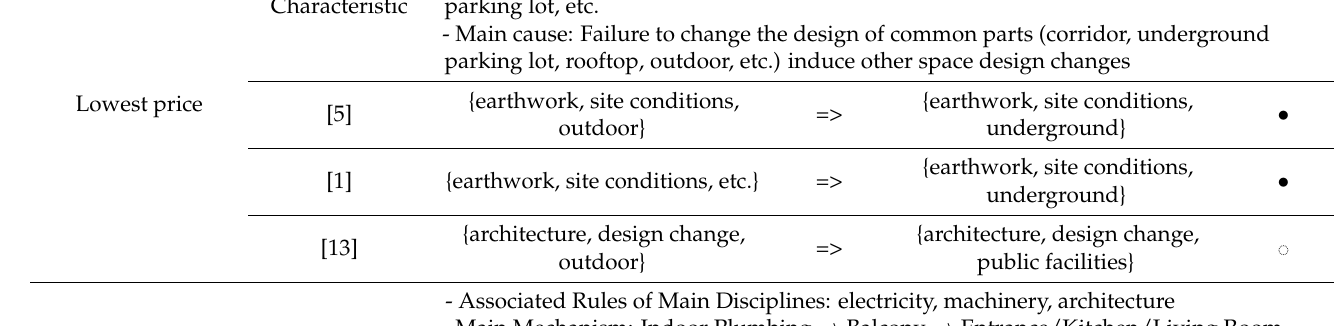
Table 3. Association rule classification system through expert interview.